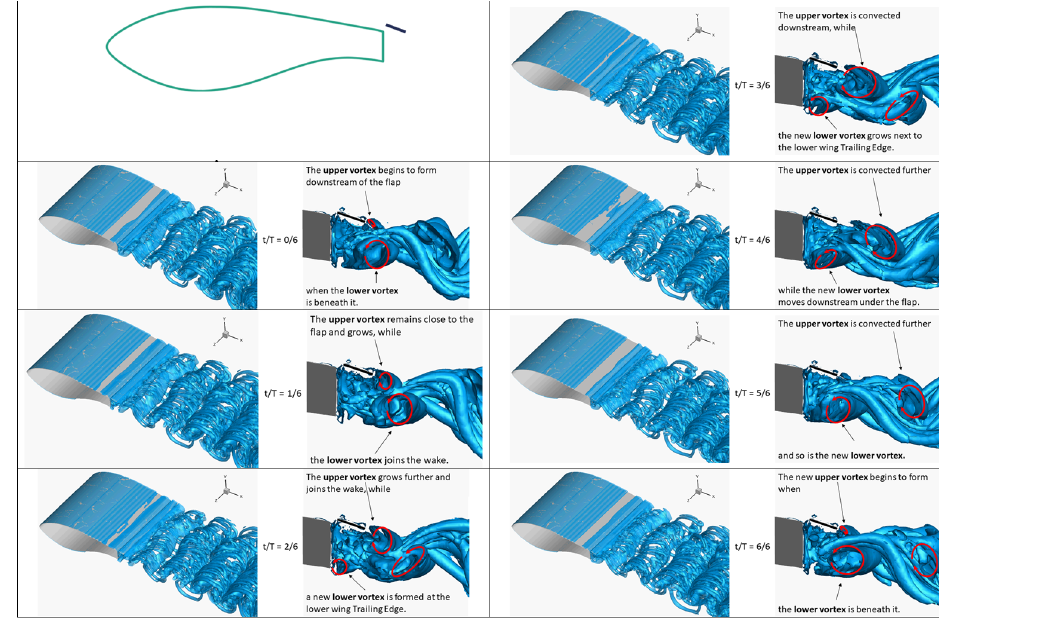
Figure A5. Snapshots of Q isosurfaces from the flap case: IDDES fine-mesh results. Each period of the vortex shedding mechanism is split in six parts and a total of 7 snapshots is shown. For each snapshot, two visualisations are shown. A 3D view of Q = 1 . 5 isosurfaces is shown on the left, and a side view of Q = 100 isosurfaces is shown on the right. Superimposed red arrows indicate interpreted spanwise vortices.